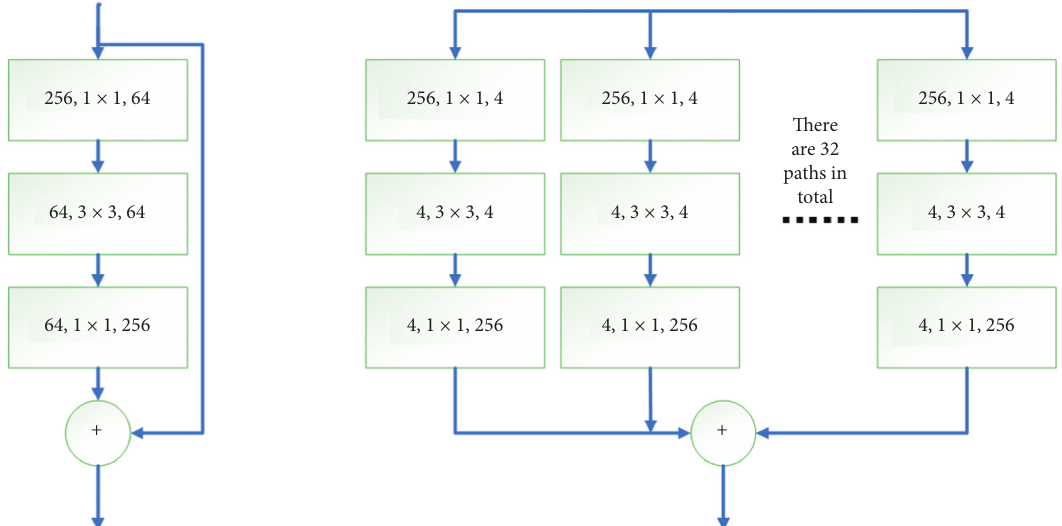
Figure 1: Comparison of residual block structures of ResNet and ResNeXt.